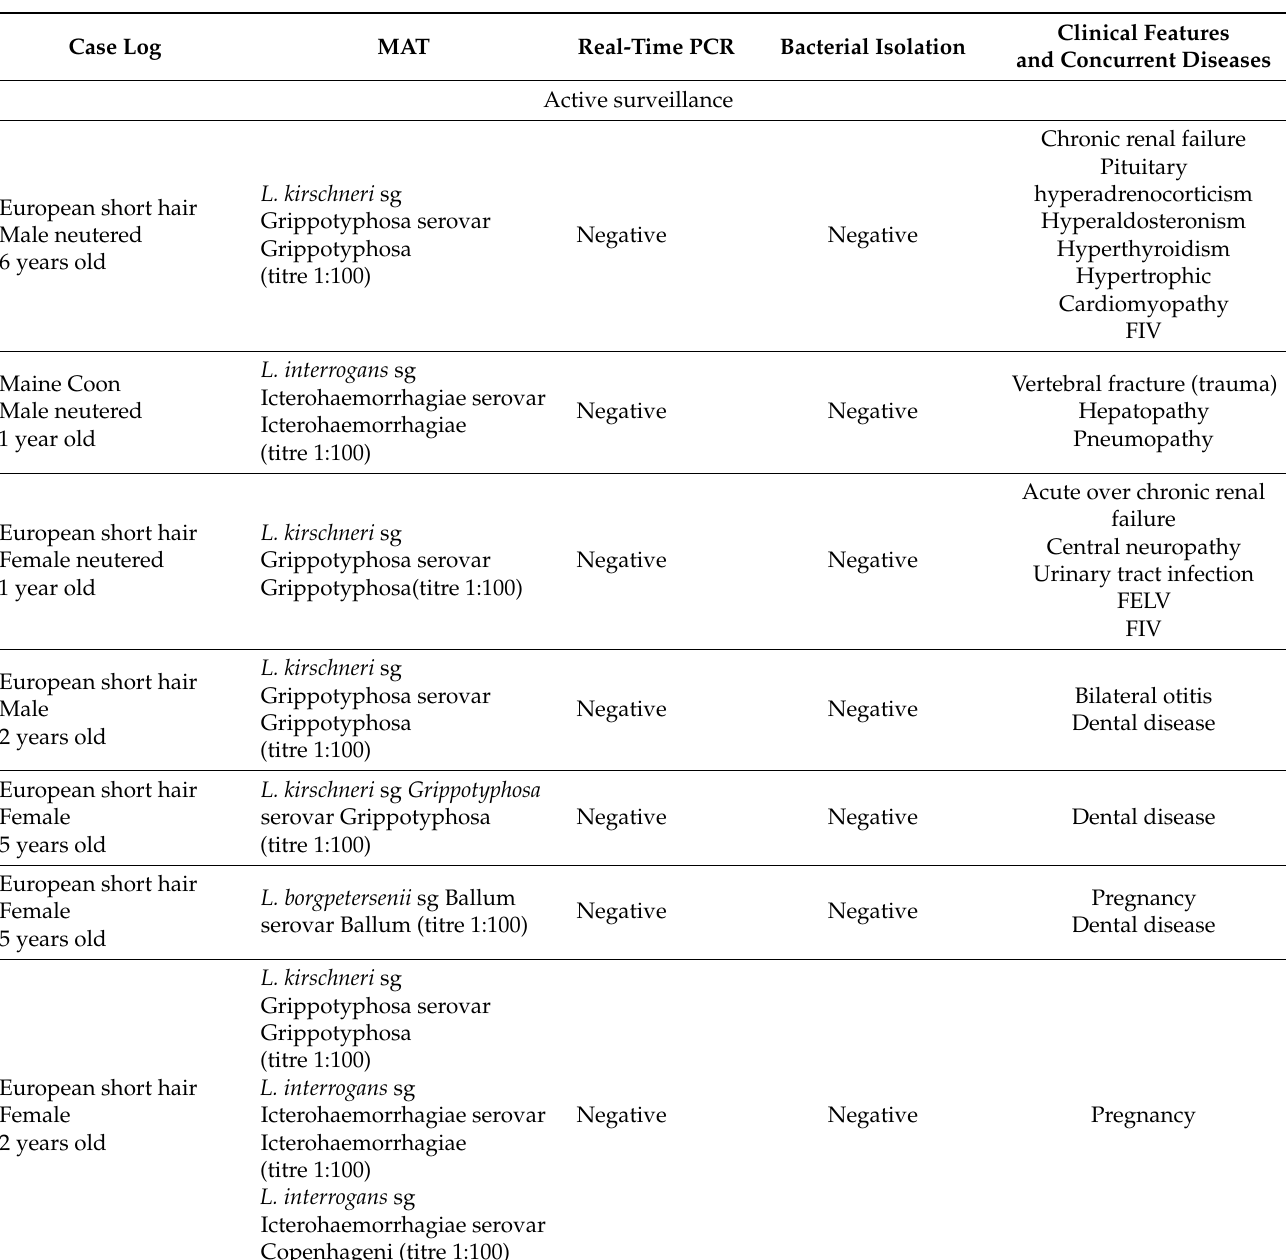
Table 1. MAT titres detected during the survey in cats (study RC 16/12); the significant clinical features and concurrent diseases (active surveillance). Clinically symptomatic cats tested positive for Leptospira spp. MAT and/or real-time PCR, and the presence of clinical signs and concurrent diseases (passive